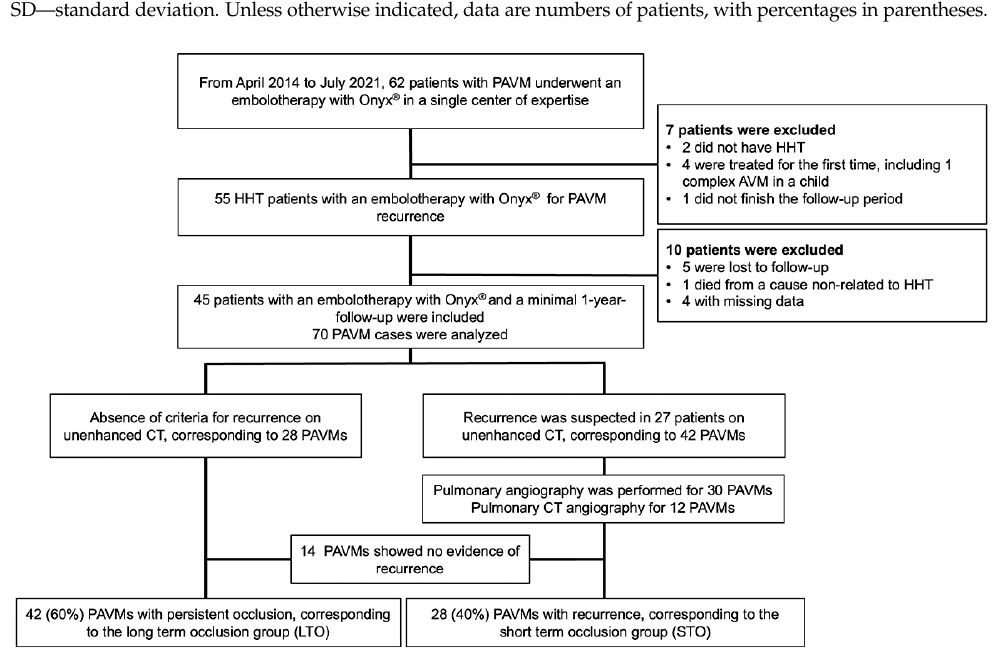
Figure 1. Study flowchart . Figure 1. Study Table 1. Characteristics of patients .